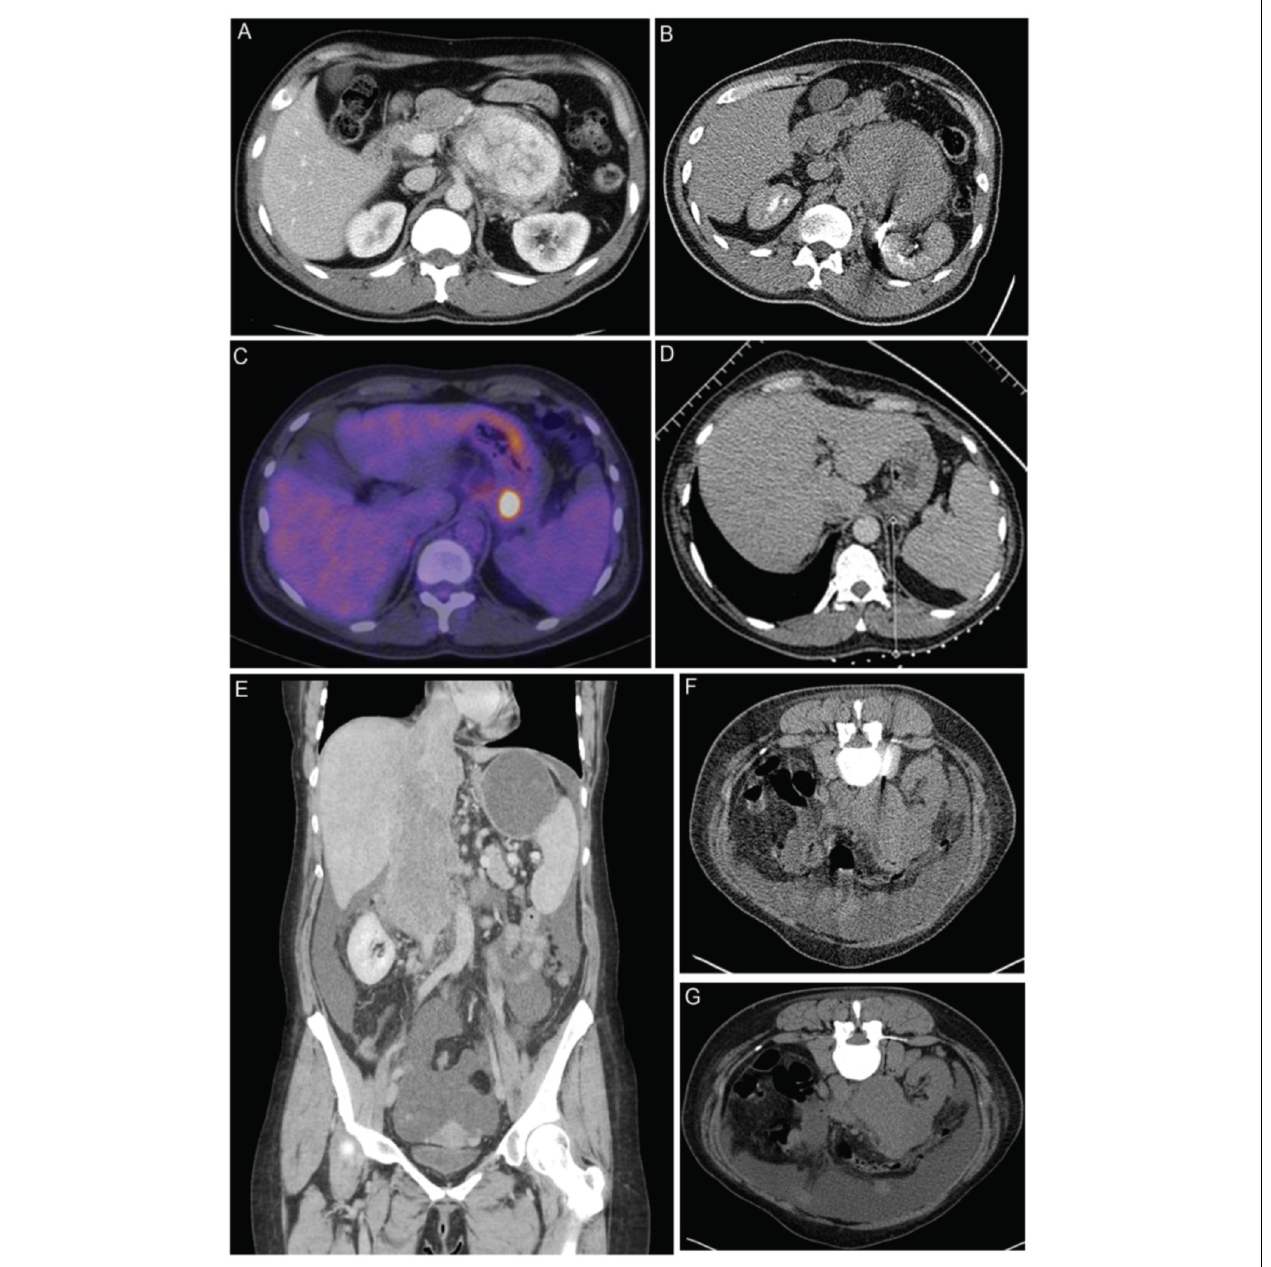
FIGURE 1 | Biopsy examples of patients within the study (A) A computed tomography (CT) of a patient with a highly vascular retroperitoneal mass thought to be too high risk to biopsy at the local hospital. Surgery was also considered to be high risk of R1/R2 resection, and a CT-guided biopsy was recommended by our multidisciplinary team (MDT). (B) Biopsy was performed with a 15-G/16-G coaxial needle. The tract was plugged with 16-G Hunter plugs, and there were no complications. The biopsy showed an inflammatory myofibroblastic tumor, which responded well on steroids and an operation was avoided. (C) PET/CT of a 57-year-old patient with relapsed Hodgkin’s lymphoma after six cycles of ABVD chemotherapy. There was response in all sites of disease with the exception of a plaque of tissue behind the fundus of the stomach, which appear [18F]-fluorodeoxyglucose (FDG) avid on PET scan. A decision of the MDT was made to biopsy the lesion in order to exclude transformation of lymphoma. (D) The 17-G coaxial needle was placed medial to the left adrenal and above the splenic vessels adjacent to the lesion. Three cores were taken, and the tract was plugged. There were no complications. The biopsy showed Hodgkin’s lymphoma, which responded well to systemic therapy and consolidation RT. (E) Coronal CT images of a 48-year-old patient with a large tumor of the inferior vena cava (IVC) extending from the level of the renal veins to the right atrium. Occluded hepatic veins and ascites can be seen on the scan. (F) The lesion was biopsied with a 15-G/16-G coaxial needle. (G) The tract was plugged with three gelfoam pledgets. A diagnosis of leiomyosarcoma of the IVC was made, and the procedure had no complications.